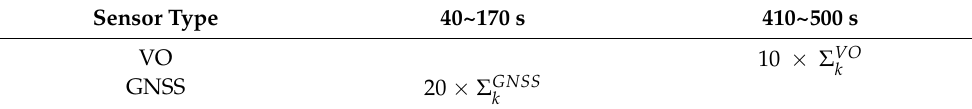
Table 2. Measurement errors of different sensors at different time periods (40~170 s, 20 times the Σ GNSS gross error is added to the GNSS positioning measurement. In the range of 410~500 s, 10 times k the Σ VO gross error is added to the VO positioning k